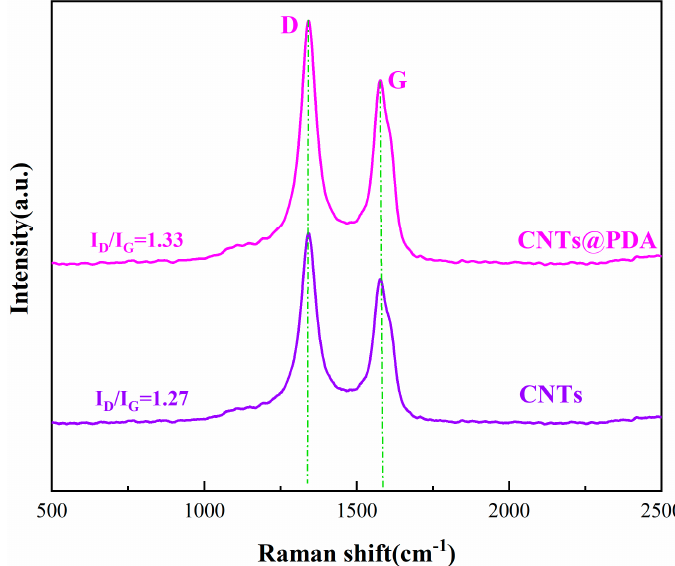
Figure 4. Raman spectra of CNTs and CNTs@PDA.